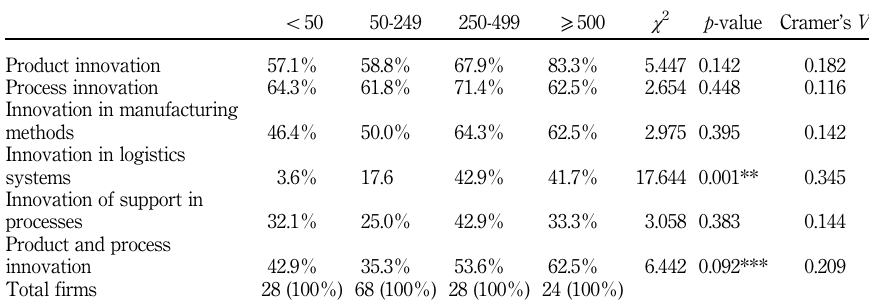
Table III. Type of technological innovation by firm